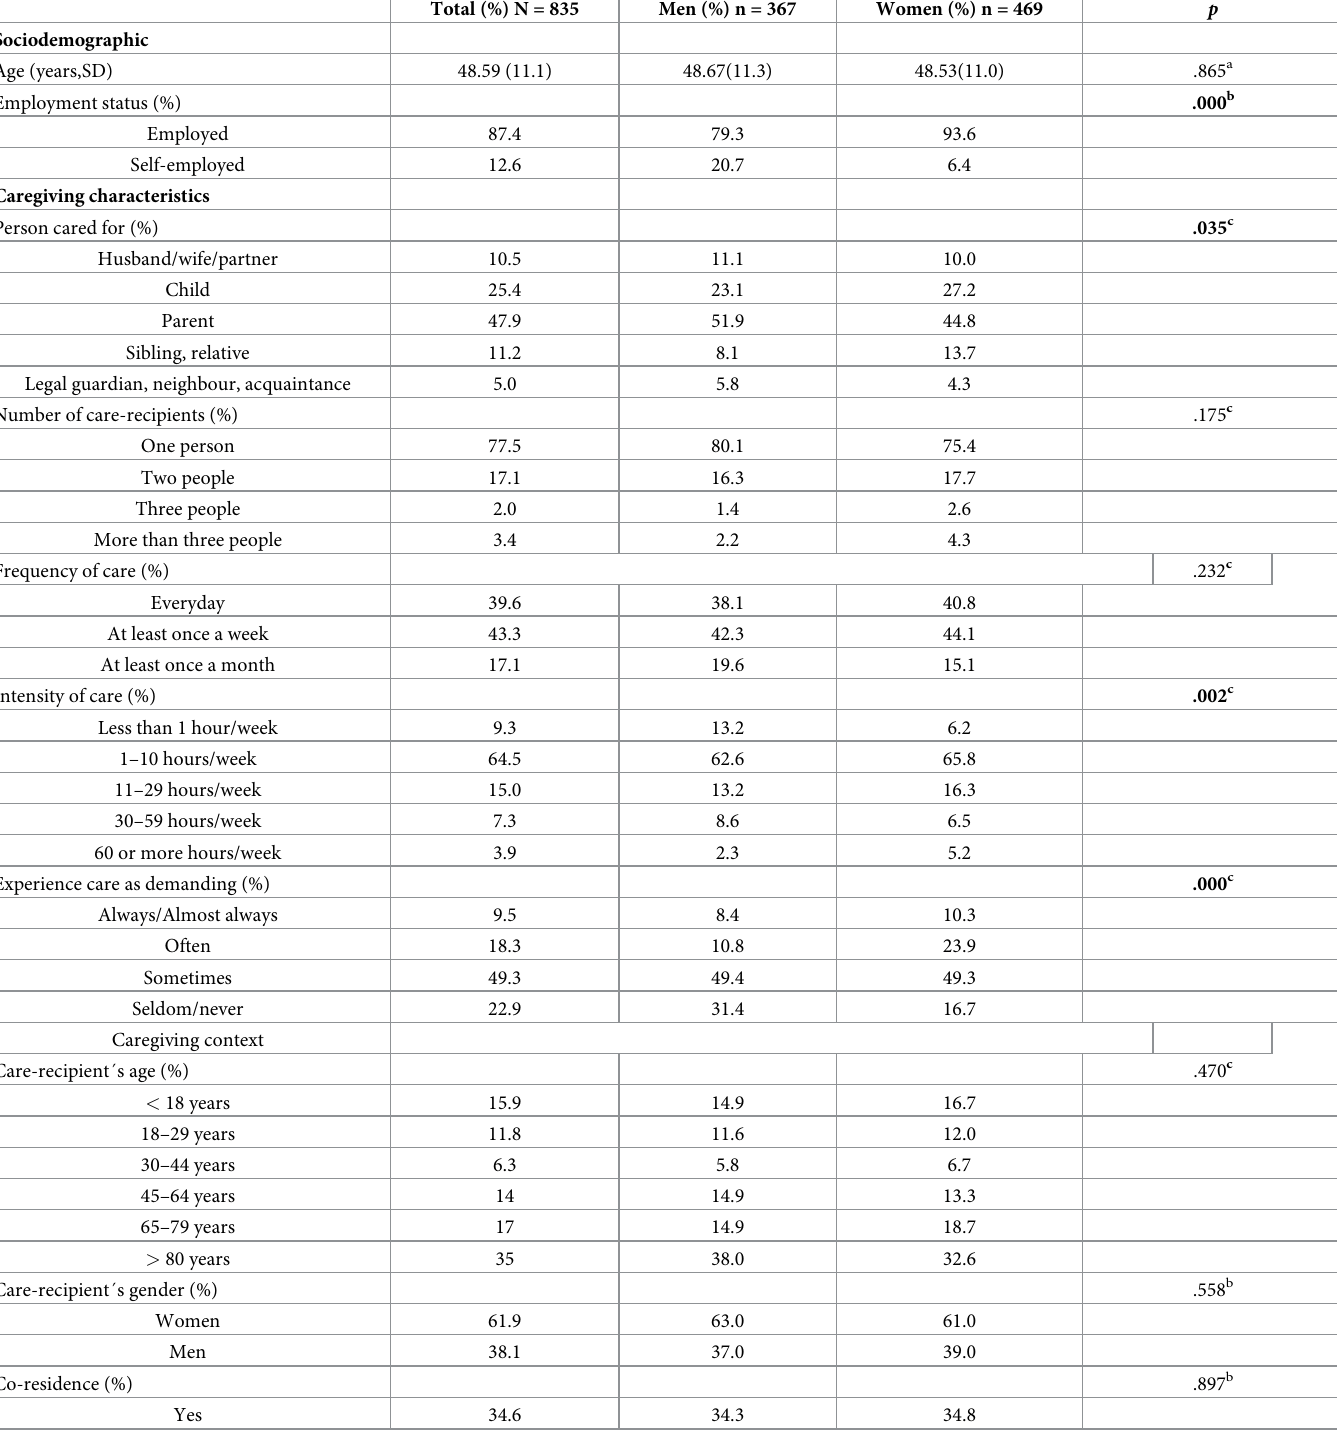
Table 1. Sociodemographic variables, caregiving characteristics and context for the total sample of working carers and by